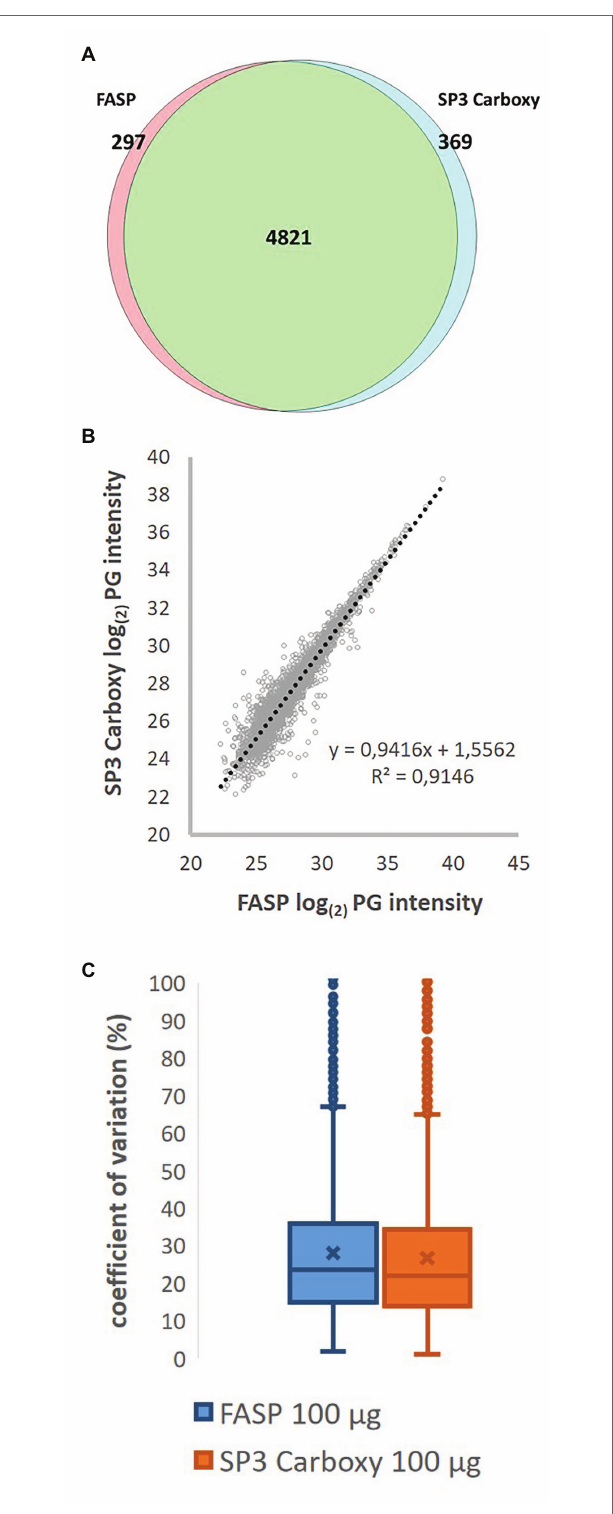
FIGURE 6 | Qualitative and quantitative comparison of FASP and Basic SP3 protocol (100 μ g protein input, pentaplicate). (A) Overlap of identified unique protein groups. (B) Scatter plot of log2 transformed intensities of shared PGs. Median intensity and median normalization approach were employed to calculate protein group intensity. (C) Coefficient of variation of shared PGs intensities.